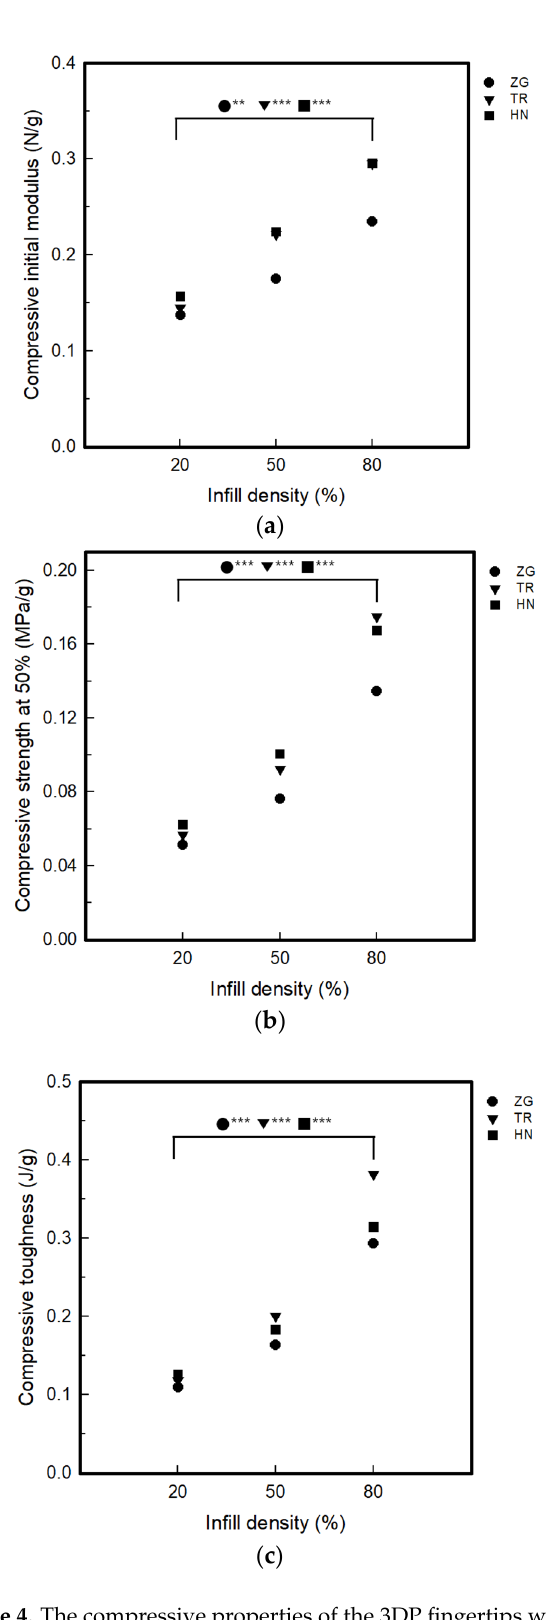
Figure 4. The compressive properties of the 3DP fingertips with various infill patterns and densities ( p -value: ** p < 0.01, *** p < 0.001): ( a ) Compressive initial modulus; ( b ) Compressive strength at 50%; ( c ) Compressive toughness.